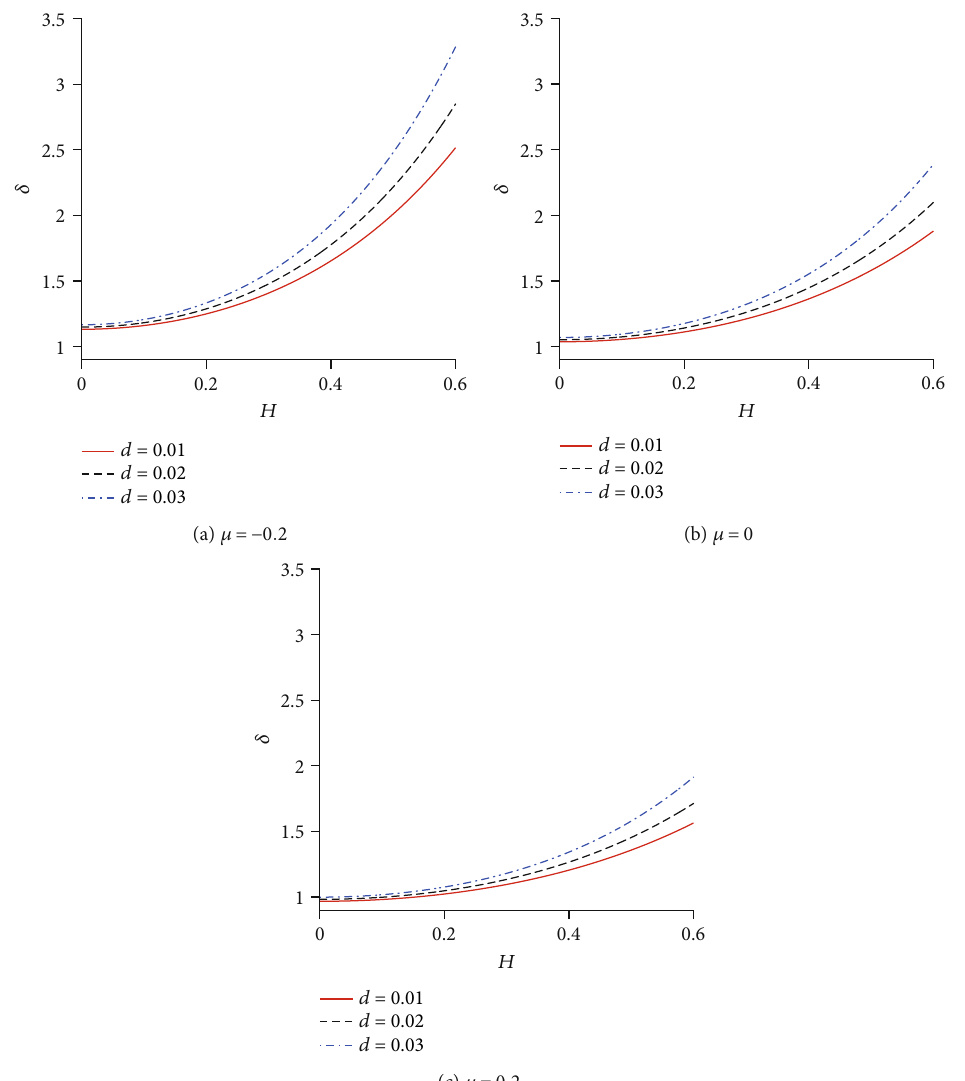
Figure 7: The in fl uence of the plate ’ s thickness d on the phase velocity δ ð = c 2 / c 2